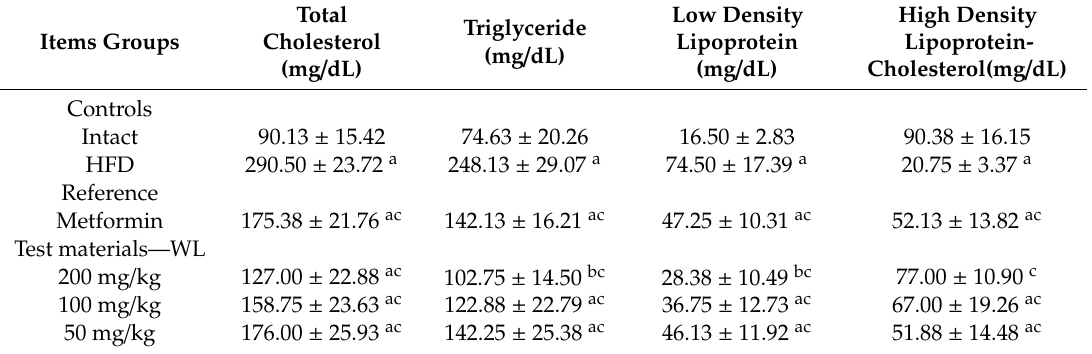
Table 9. Changes in blood glucose levels and serum lipid contents in NFD or HFD supplied